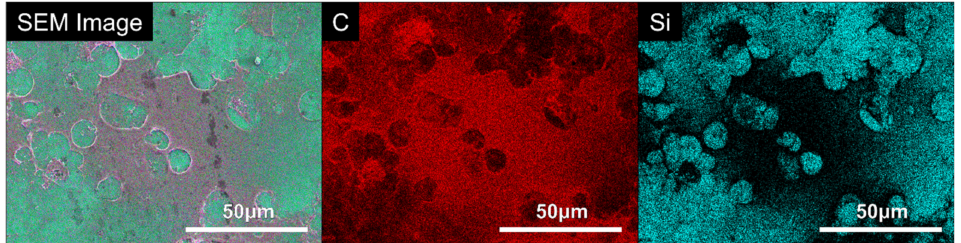
Figure 7. EDX analysis of the U-2 OS film formed on the square glass cover slips coated with the PDDA coating.